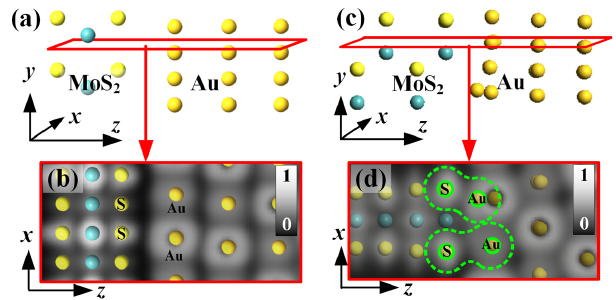
FIG. 22. (a),(c) The cleaved x - z planes (red rectangles) used to show electron localization functions (ELF) for (a) Au-MoS 2 top contact and (c) Au-MoS 2 edge contact. (b),(d) ELF plots on the cleaved x - z plane in Au-MoS 2 (b) top contact, (d) edge contact. Half-transparent dots indicate positions of atoms. High ELF (closer to 1) indicates high probability of finding an electron. For FIG. 20. PDOS of mTMD near E of edge contacts to (a) – F edge contact, Au-MoS 2 has overlapping electron orbitals (Au-S bonds, indicated by green dashes) resulting in the increasing of electron density as shown in Fig. 21. Thus, the contact resistance is reduced by using edge